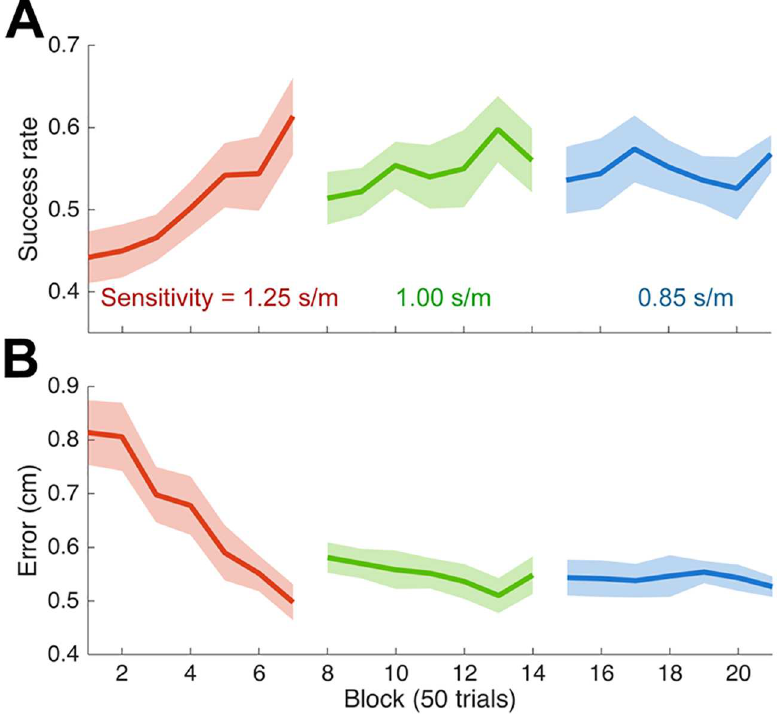
Fig 7. Performance in Experiment 2. (A) Success rate across blocks (mean ± s.e. across subjects) for the three visual sensitivities. (B) Error in the same format as (A).